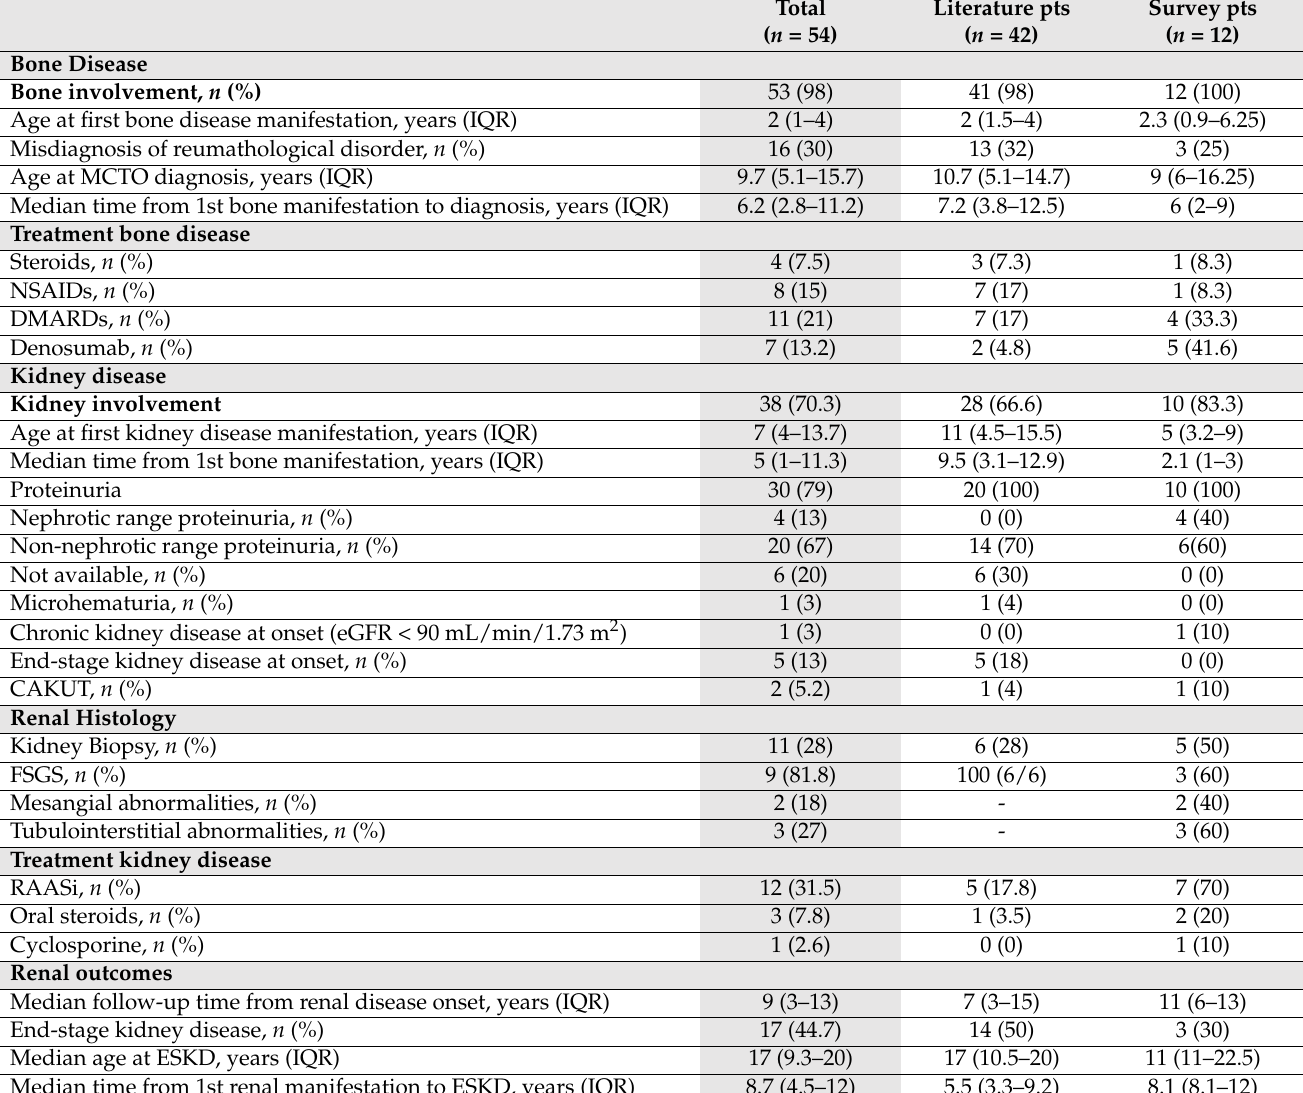
Table 1. Patients’ characteristics of bone and kidney